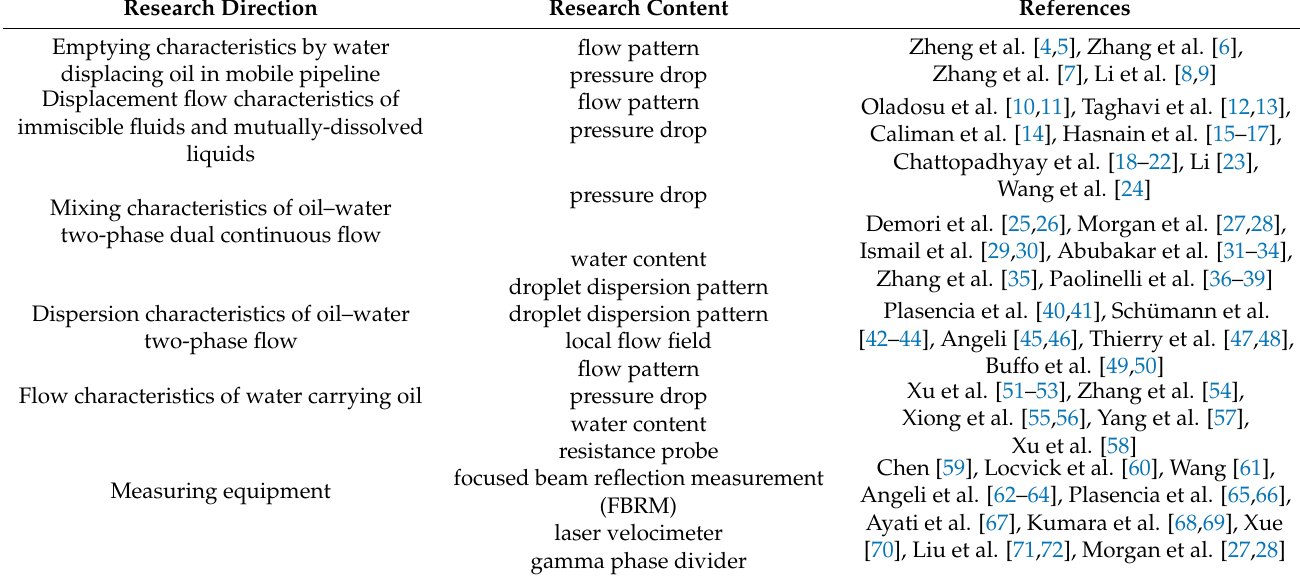
Table 1. Summary of oil–water flow